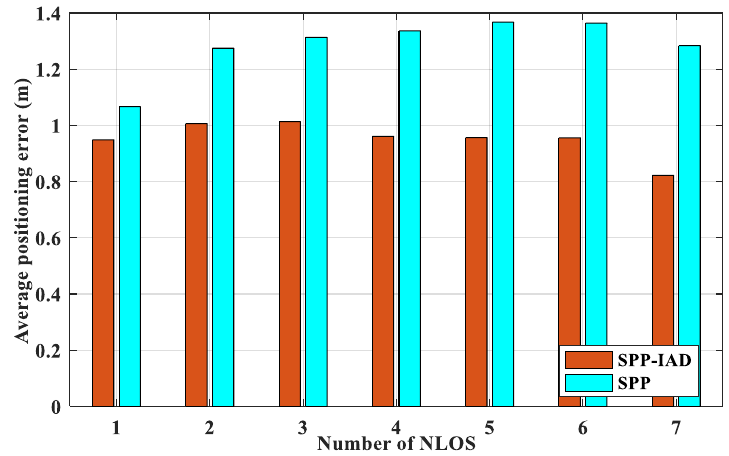
Figure 15. Average positioning error with different numbers of NLOS signals.